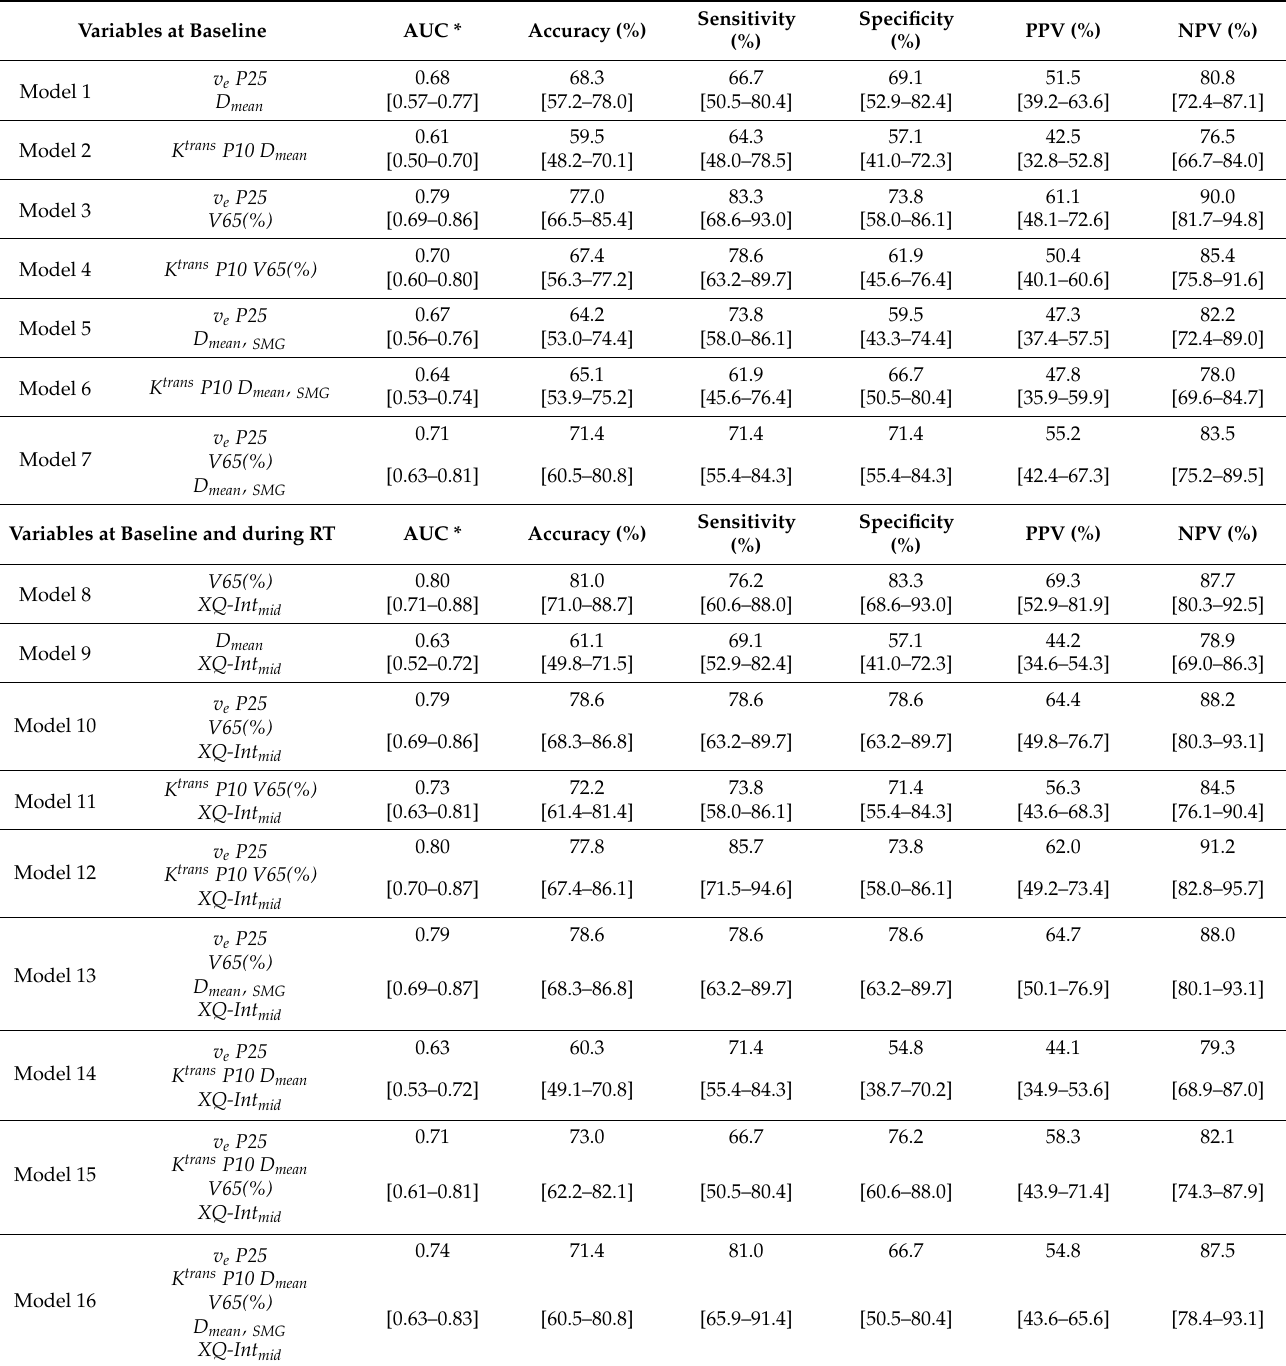
Table 3. Predictive Performance of the models including variables at